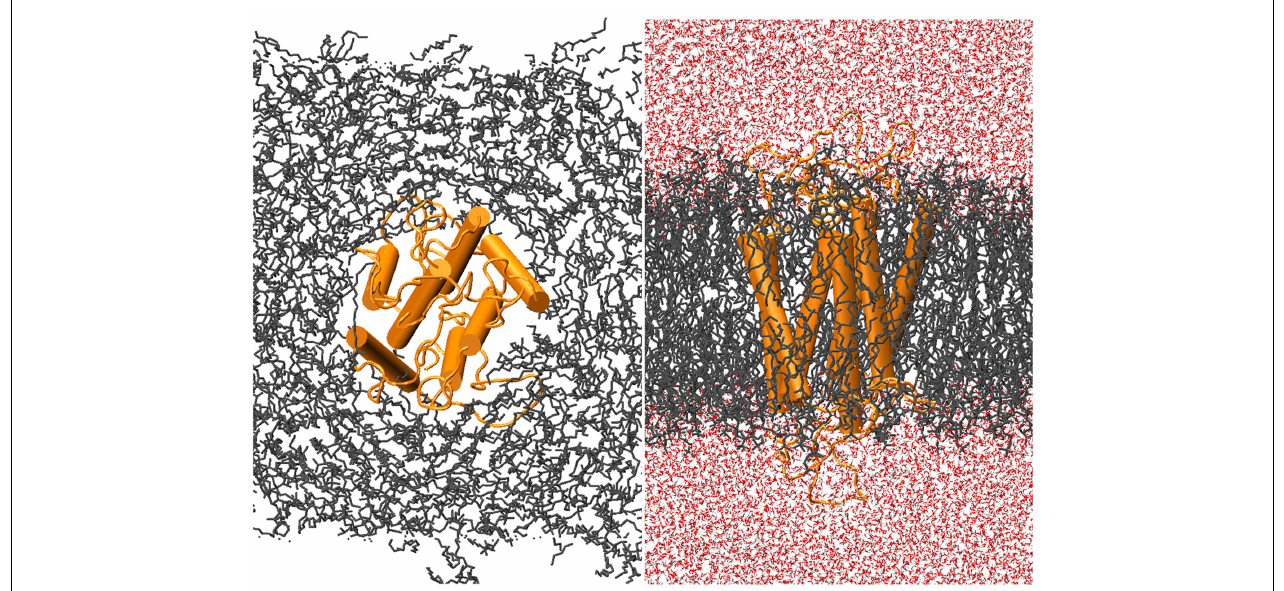
FIGURE 5 | hOR17-209 is embedded into the lipid bilayer-solvent complex with g_membed. The receptor, lipids, and waters are colored orange, gray, and red,